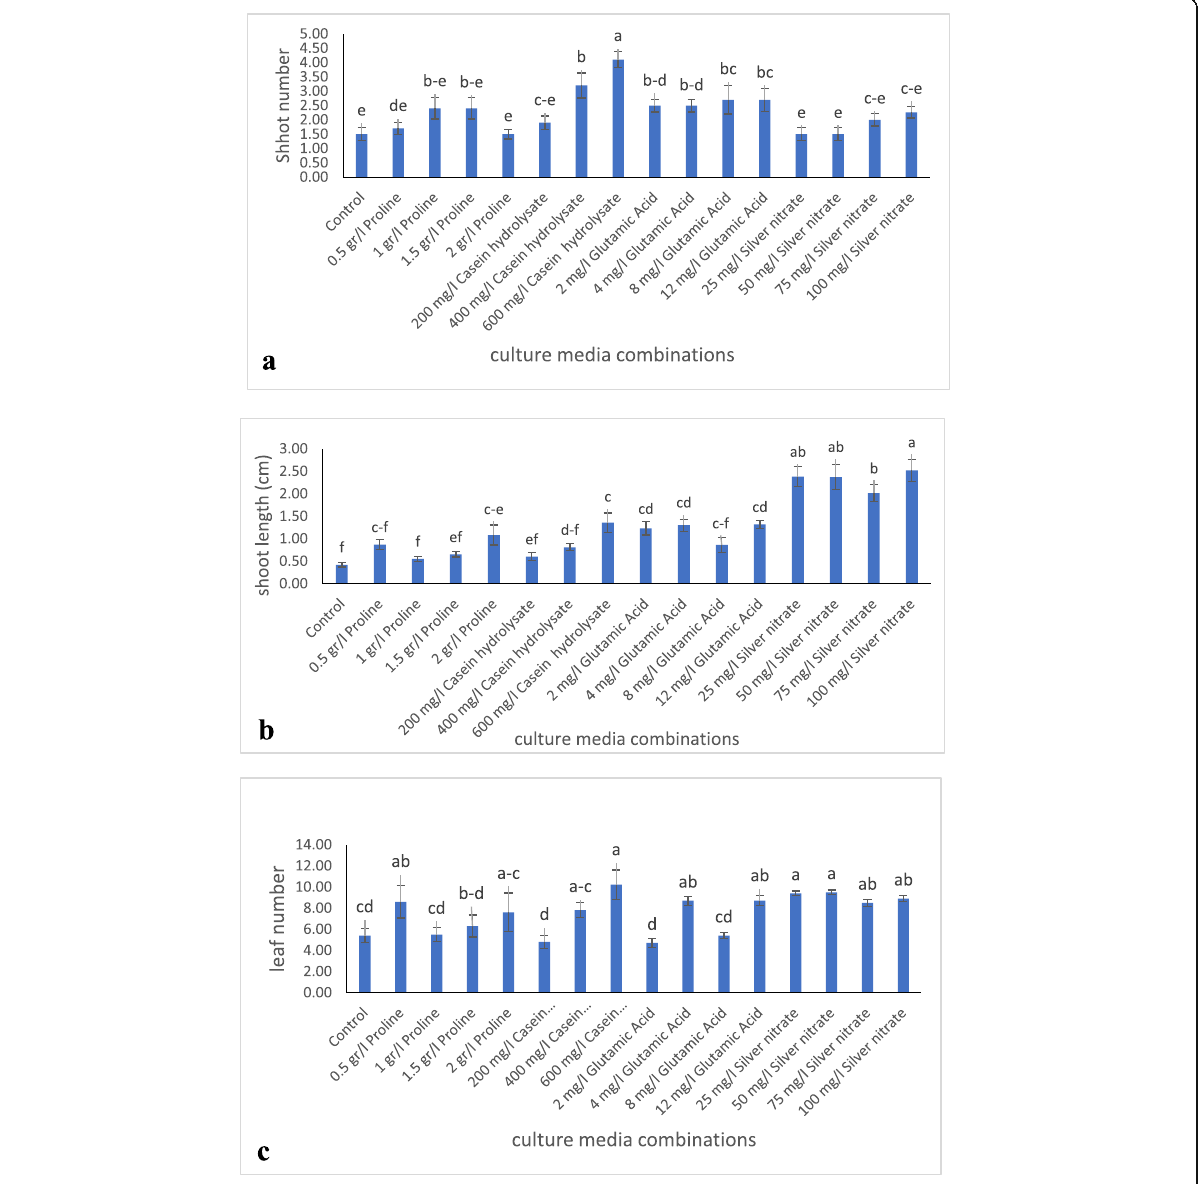
Fig. 1 Effect of various growth additives on a regenerated shoot number, b shoot length, and c leaf number of Rosa canina nodal explants in vitro condition. Mean values with different letters are significantly different at p <